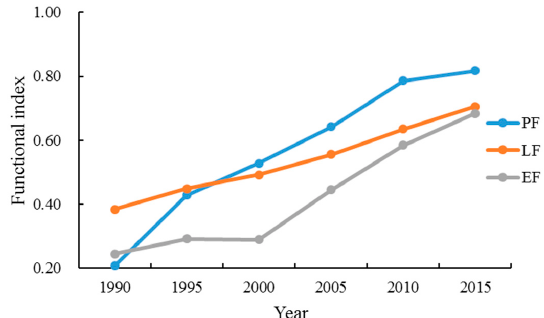
Figure 4. Changes in the production-living-ecology land use functions of the Beijing-Tianjin-Hebei